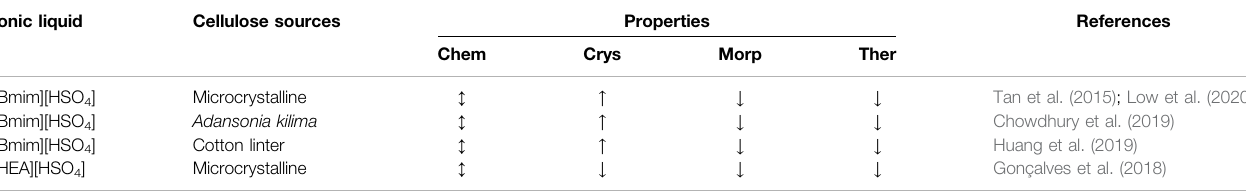
TABLE 7 | Properties of nanocellulose extracted by hydrogen sulfate anion-based ionic liquids. Ionic liquid Cellulose